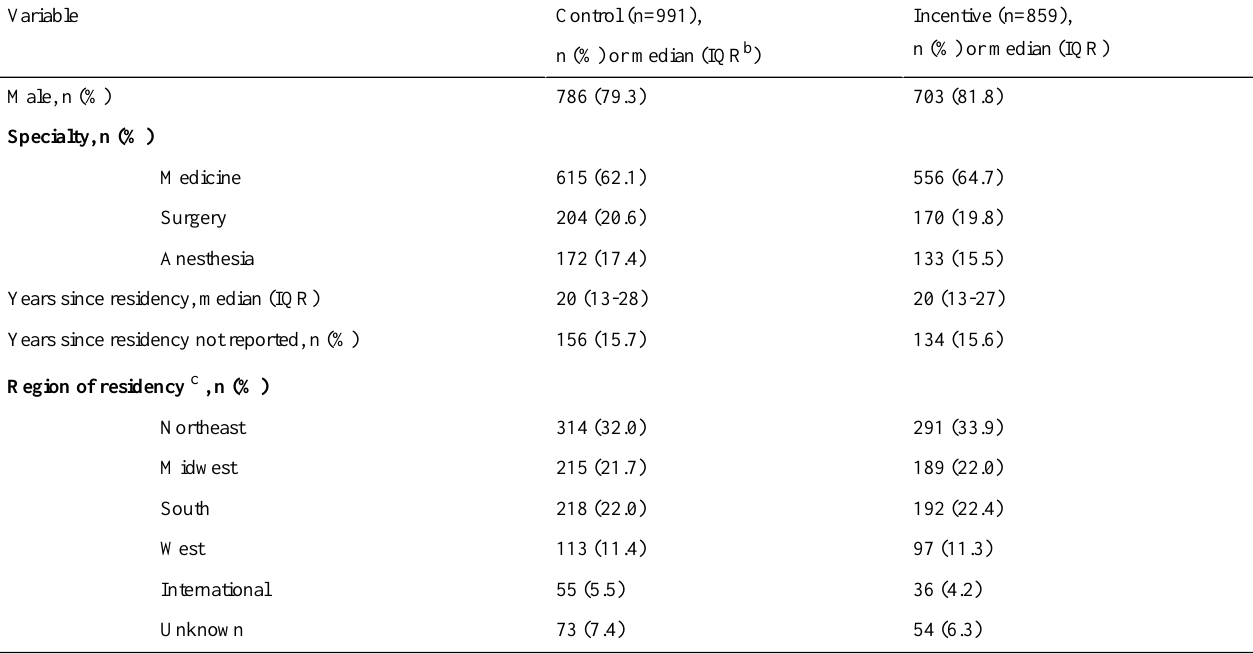
Table 2. Characteristics of the study population a